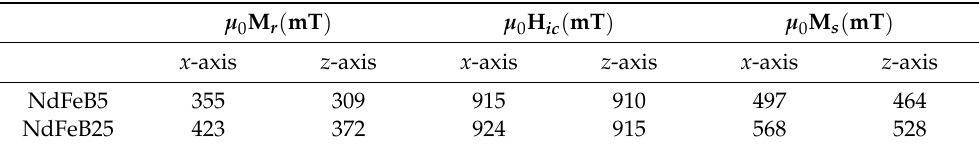
Figure 5. Magnetic curves of the PowderMEMS micromagnets, fabricated using NdFeB powder of particle sizes d50 = 5 µm (NdFeB5) and d50 = 25 µm (NdFeB25). Hysteresis loops of the micromagnets measured in direction of ( a ) x-axis and ( b ) z-axis at room temperature. ( c ) Cross-sectional schematic of the measured micromagnet structure. Table 1. Magnetic properties of the PowderMEMS NdFeB micromagnets with dimensions of ( 2000 × 2000 × 530 ) µ m 3